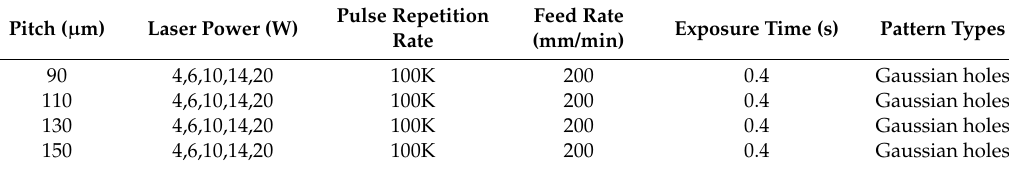
Figure 3. Experimental setup for laser machining trials. Table 2. The laser machining parameters with varied laser power and pitch.